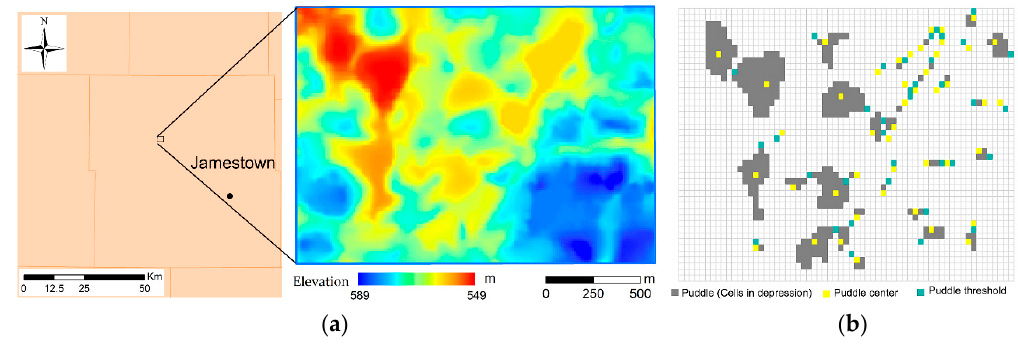
Figure 6. ( a ) Location of the selected surface; ( b ) delineated depressions/flats based on the original DEM.